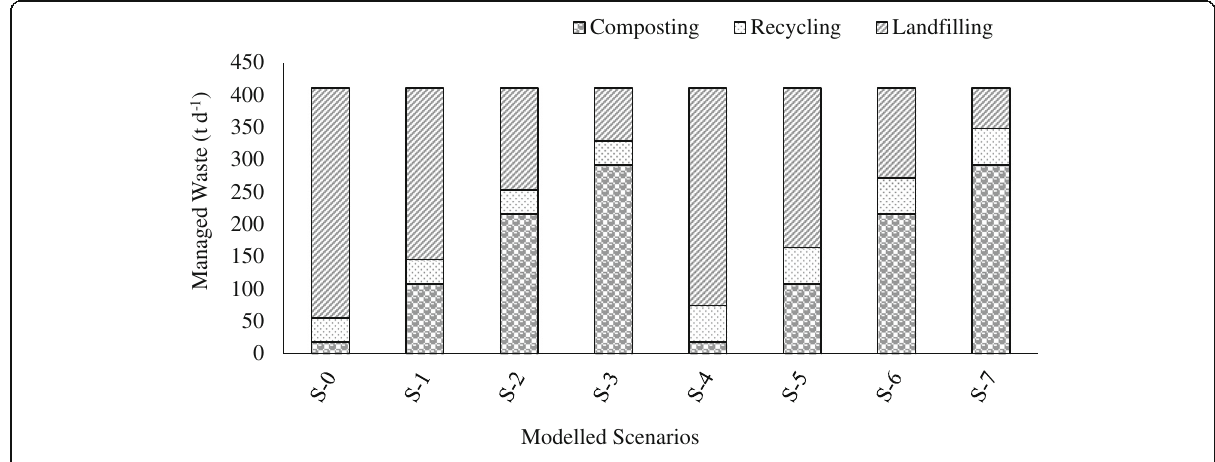
Fig. 3 Amount of managed waste at different modelled scenarios